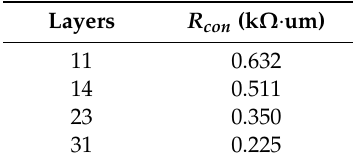
Table 2. R con of di ff erent layers from Equation (6).